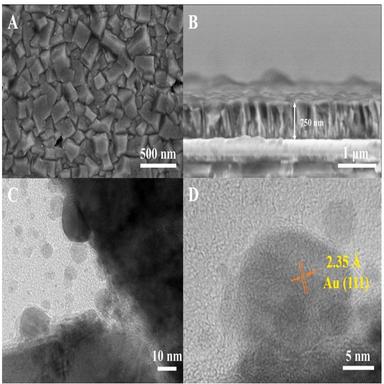
(A) FESEM image of ITO/Au/Cu2O. (B) Cross-sectional SEM image of ITO/Au/Cu2O. (C) and (D) are HR-TEM images of Au NPs in different magnification.